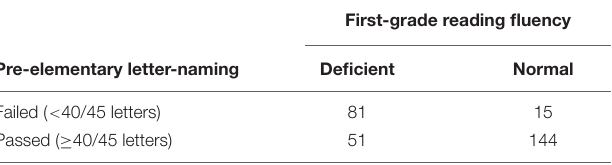
TABLE 4 | Contingency table for the optimal Hiragana-naming